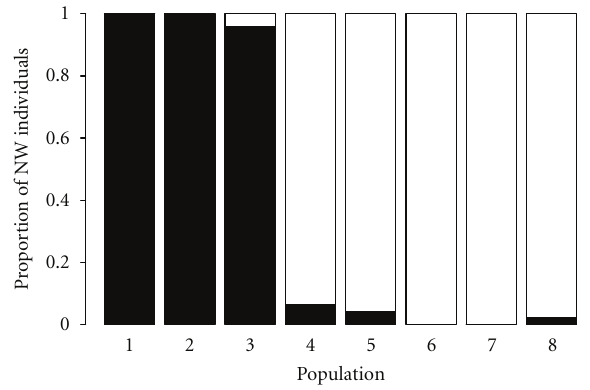
Figure 4: Proportion of individuals from the NW (black) and C (white) mitochondrial lineages along the combined transect.